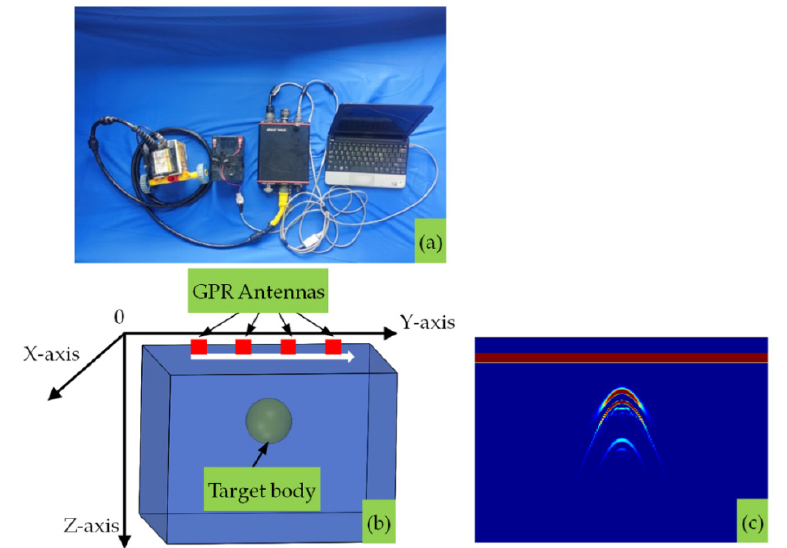
Figure 1. Schematic diagram of GPR detection and imaging. ( a ) Components of GPR instruments; ( b ) detection process of underground target body; ( c ) GPR profile of a survey line.